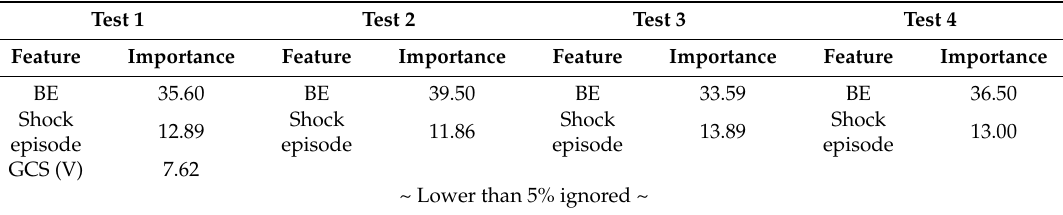
Table 3. Feature importance of 72 h mortality prediction by Random Forest (RF) (%).